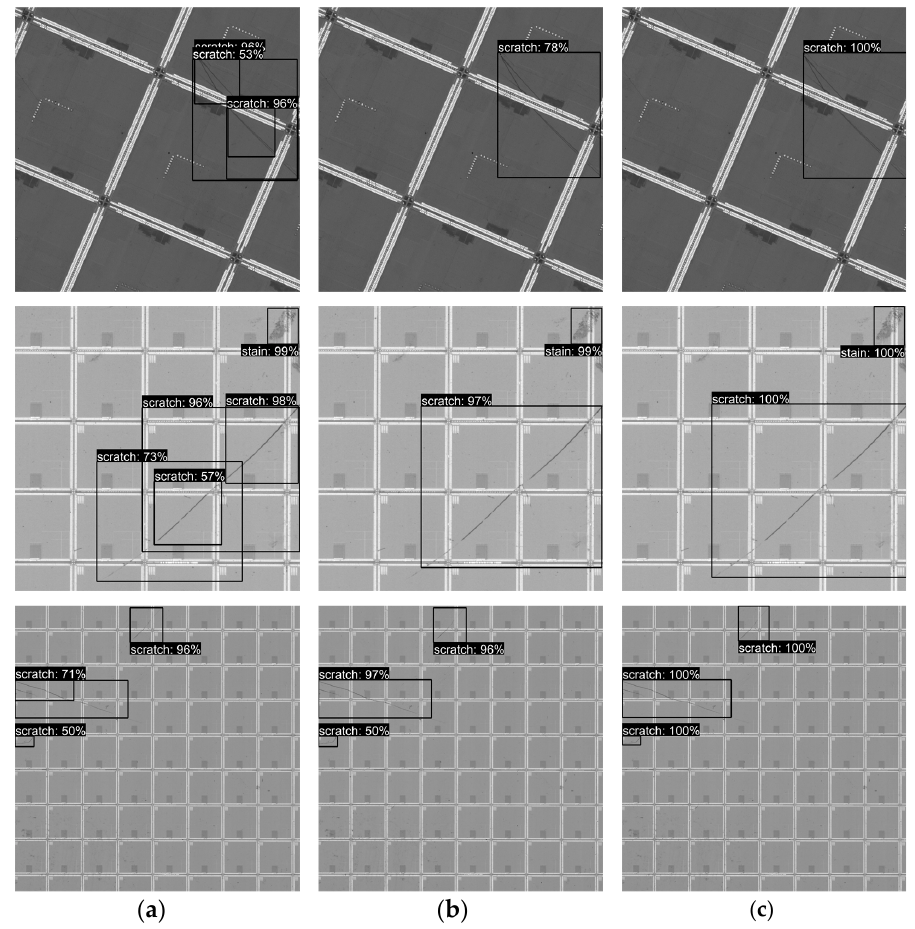
Figure 8. Comparison of predicted boxes before and after aggregation: ( a ) raw detection results, ( b ) bounding boxes after predicted box aggregation, and ( c ) annotation.